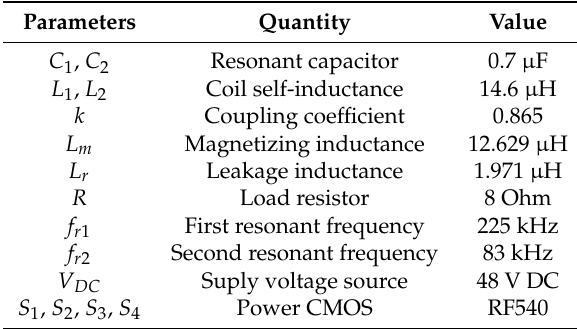
Figure 20. Experiment platform of the system. Table 1. System parameters.